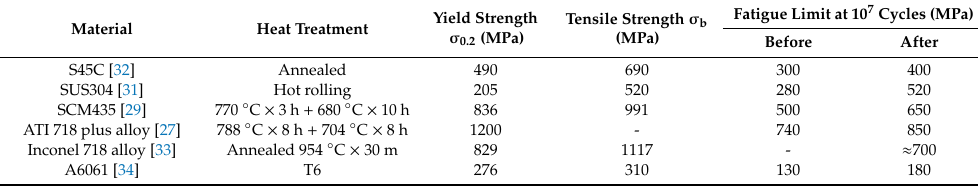
Table 4. Enhancement of rotating-bending fatigue limit by ultrasonic surface